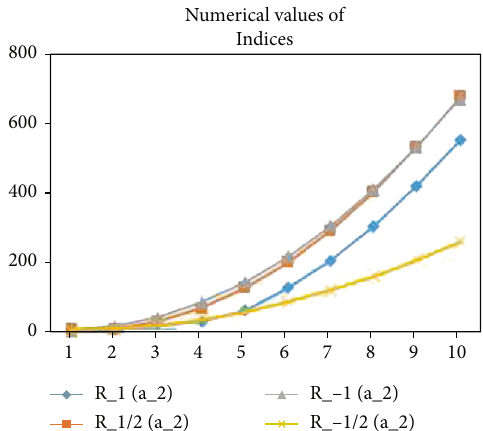
Figure 6: Comparison of indices for THDN4 ð 7 Þ